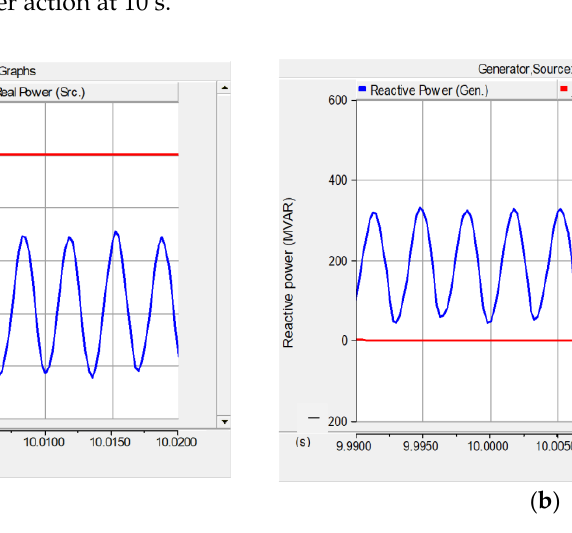
Figure 26. ( a ) Real power; ( b ) reactive power.